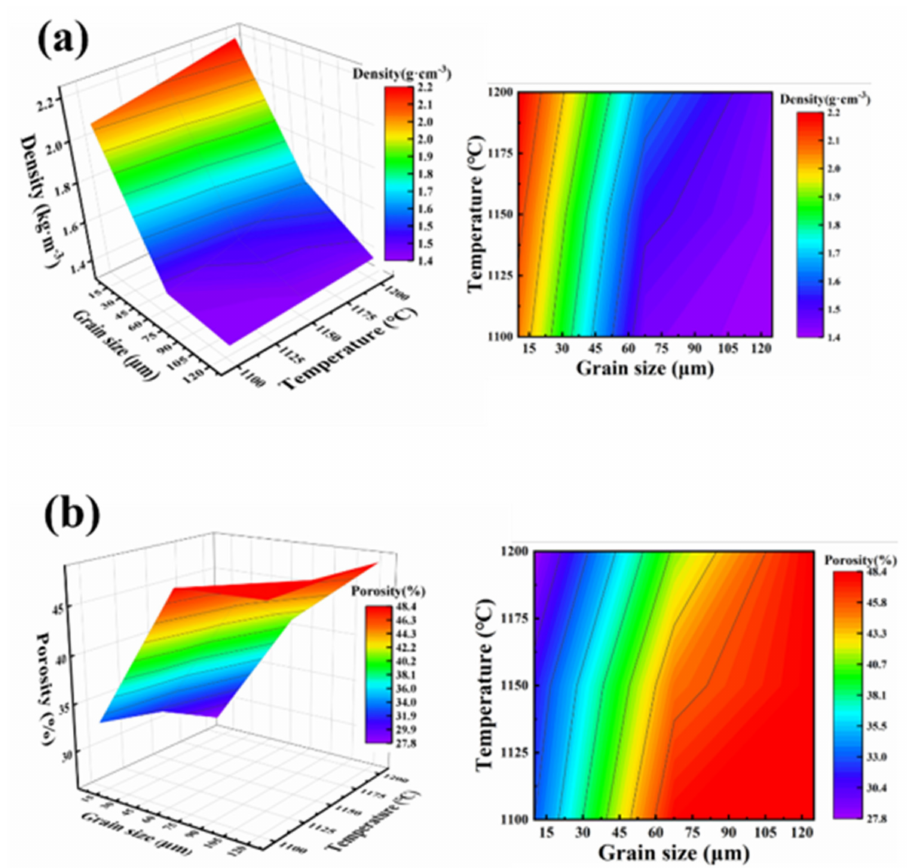
Figure 6. ( a ) Density distribution of porous Al 2 O 3 ceramic membrane tubes with different grain sizes and sintering temperatures; ( b ) Porosity distribution of porous Al 2 O 3 ceramic membrane tubes with different grain sizes and sintering